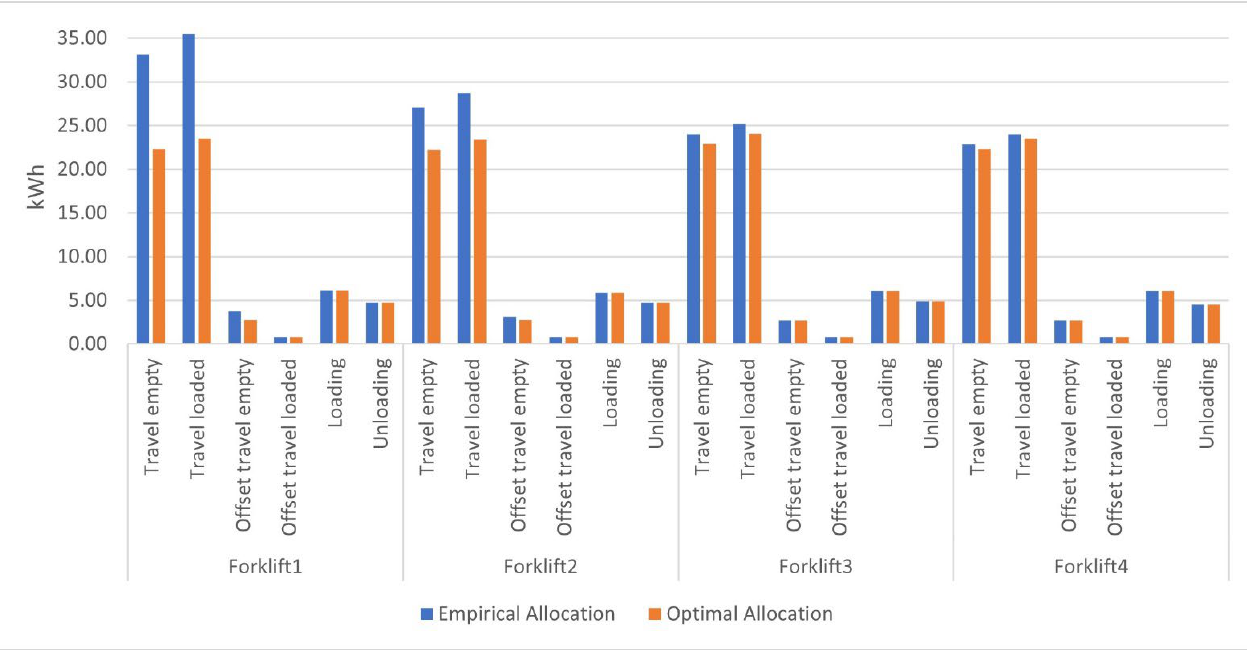
Figure 5. Energy consumption of the forklifts in two scenarios. The percentage shares of the forklifts’ energy consumption in performing each of the monitored inbound docking operations, in both scenarios:—(a) empirical dock doors al- location and (b) optimal dock doors allocation—are depicted in Figure 6.